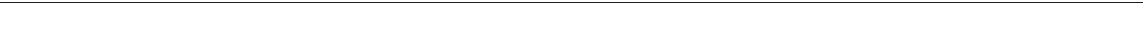
Fig. 2 APC2 clusters localize to microtubule bundles in dendrites. a Three constructs were made for these experiments based on human APC2 sequence. b Localization of RFP-APC2 was assessed throughout development of neurons at DIV3 ( n = 18), DIV7 ( n = 19) and DIV15 ( n = 15) by measuring PI, N = 2. c Localization pattern of RFP-APC2, RFP-APC2- Δ C and RFP-APC2-C in DIV16 neurons immunostained for axon initial segment (TRIM46) and dendrites (MAP2). d RFP-APC2 localizes in a regular pattern clusters in primary dendrites. d.1 and d.2 are secondary dendrites, where RFP-APC2 often localizes to the outer dendrite. Line scans highlight the clustered pattern localization. e RFP-APC2 clusters colocalize with tyrosinated and acetylated microtubule bundles in neurons. Colocalized pixels are white, non-colocalized RFP-APC2 pixels are red and non-colocalized tubulin pixels are green ( n = 21 areas, 0.42 ± 0,03 Manders ’ coef fi cient for acetylated tubulin and 0.39 ± 0.03 Manders ’ coef fi cient for tyrosinated tubulin, p = 0.484, Independent samples t -test). f Representative frames, color-coded maximum projections of 180 frames and kymographs of RFP-APC2 or RFP-APC2- Δ C in dendrites at DIV15 – 16. g Immobilized clusters were quanti fi ed as a percentage of total over 3 min movies taken every 0.5 s in 6.7 µ m long stretches of dendrite. ( n = 31 dendrites RFP-APC2, n = 13 dendrites RFP-APC2- Δ C, p ≤ 0.001, N = 4, Mann – Whitney U test). h Neurons transfected with RFP-APC2 were imaged on DIV16 after treatment with 10 µ M nocodazole. Kymograph is of 90 min movie with frames taken every 1 min. i Fluorescence intensity of RFP-APC2 was quanti fi ed